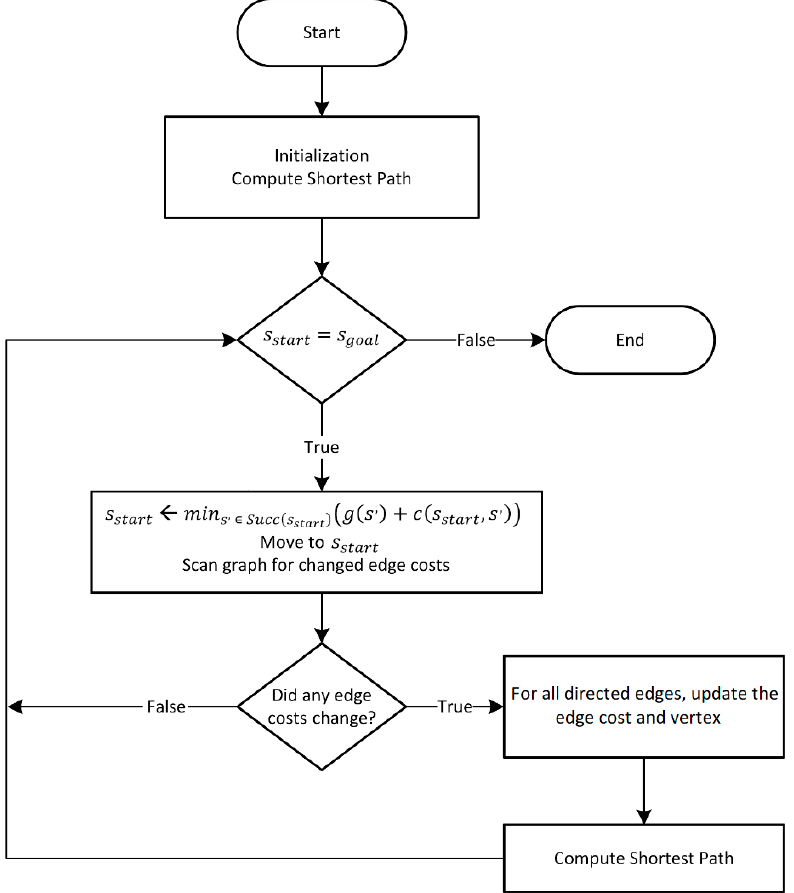
Figure 8. D* Lite algorithm flow chart.